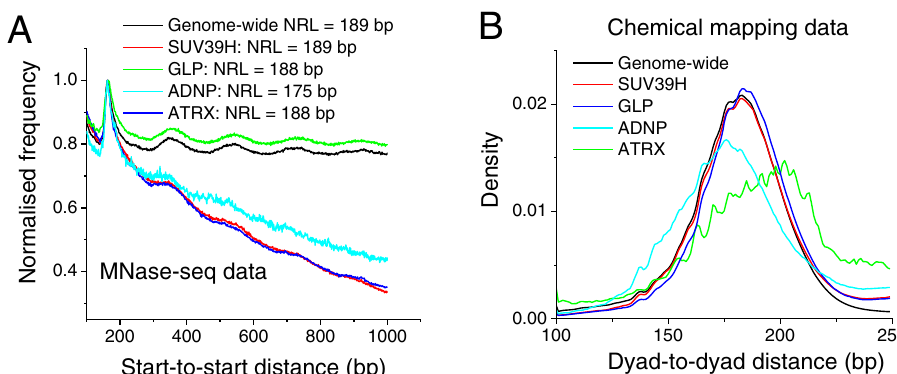
Fig. 5 Nucleosome packing characteristics in different HND types. A Nucleosome start-to-start genome-wide distance distribution (black line) based on MNase-seq 54 in SUV39H- (red), GLP- (green), ADNP- (light blue) and ATRX-HNDs (dark blue). B Nucleosome dyad-to-dyad distance distribution for nearest-neighbour nucleosomes based on chemical mapping 44